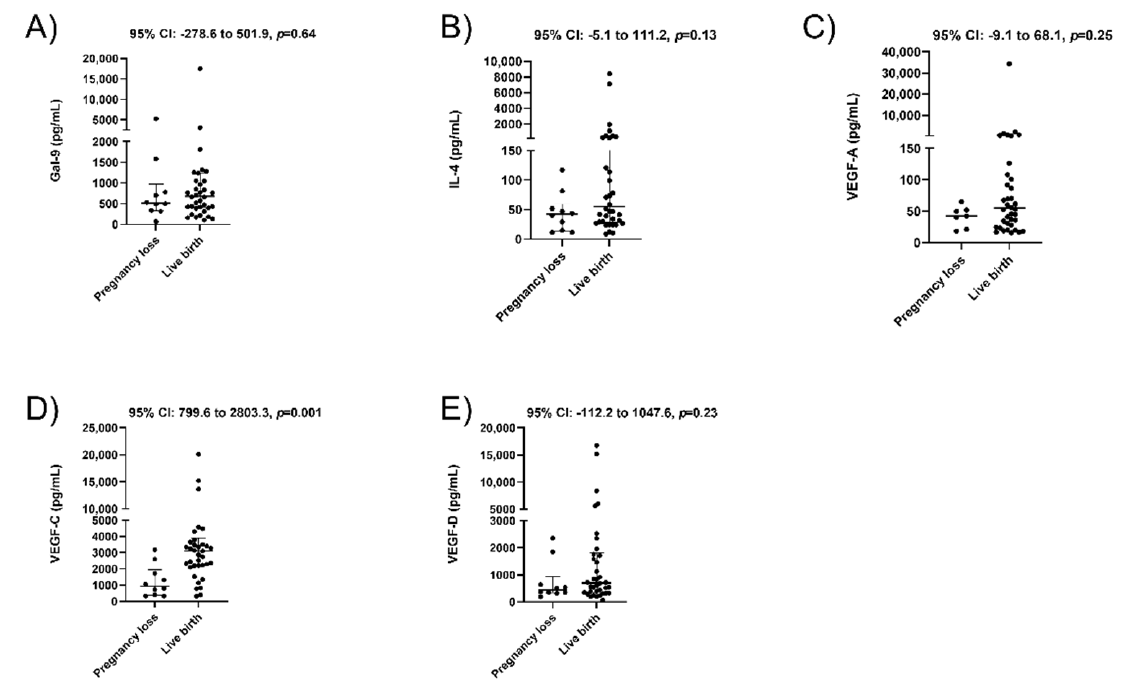
Figure 2. Plasma concentrations of immune tolerance markers and angiogenic factors among women who experience pregnancy loss versus live birth. Concentrations of Galectin-9 ( A ), IL-4 ( B ), VEGF-A ( C ), VEGF-C ( D ), and VEGF-D ( E ) as measured by ELISA. Data are displayed as median with interquartile range along with 95% CI for the median difference between groups above each panel.